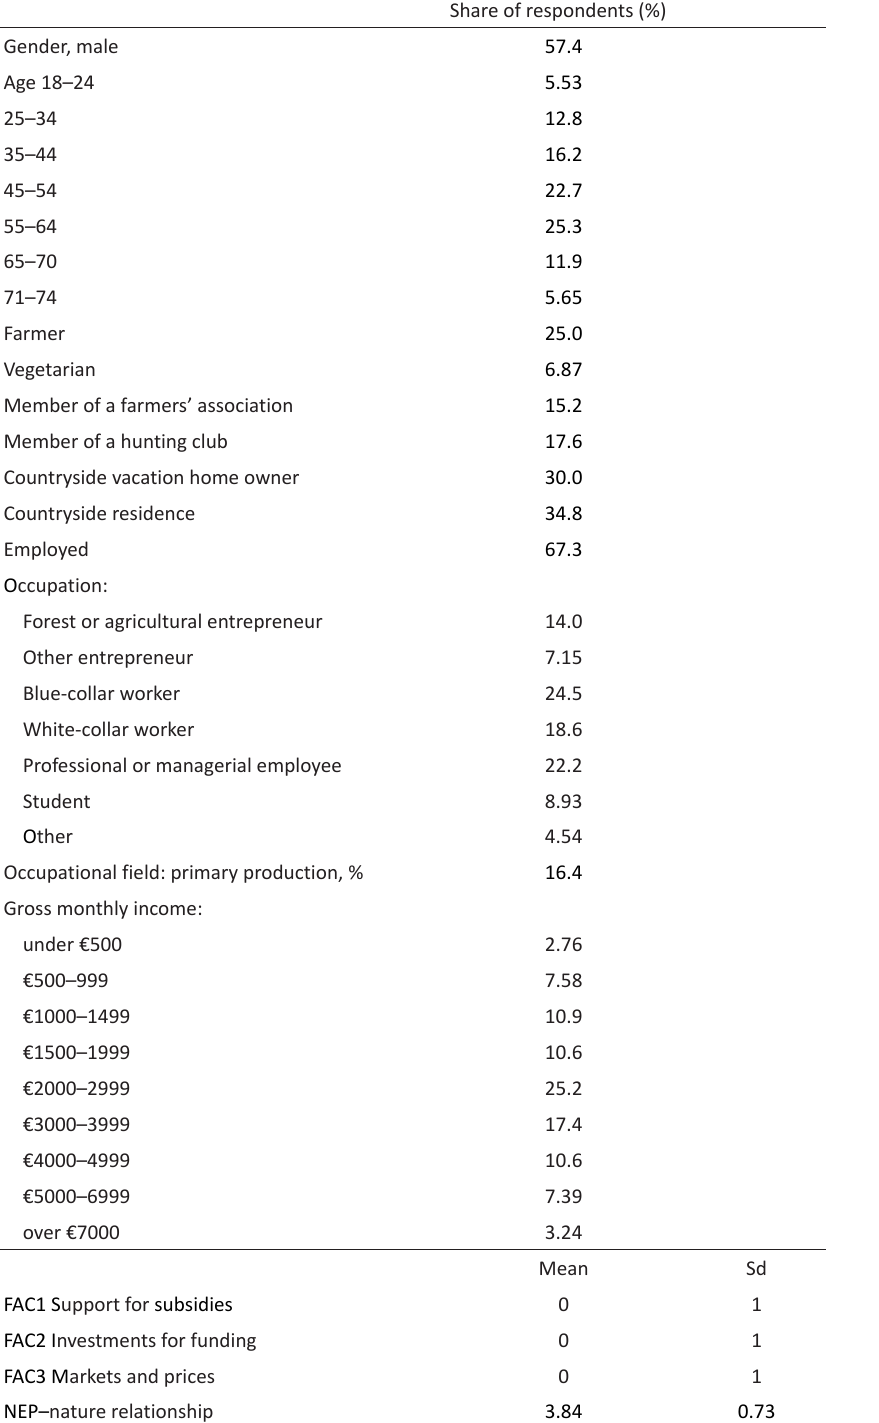
Table 2. Socio-demographic and attitudinal